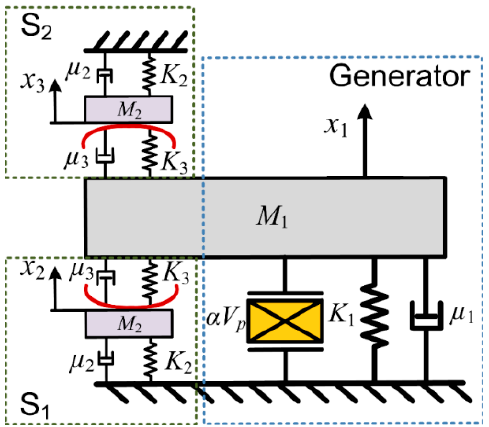
Figure 3. Model for the generator with the proposed mechanical-switch structure.